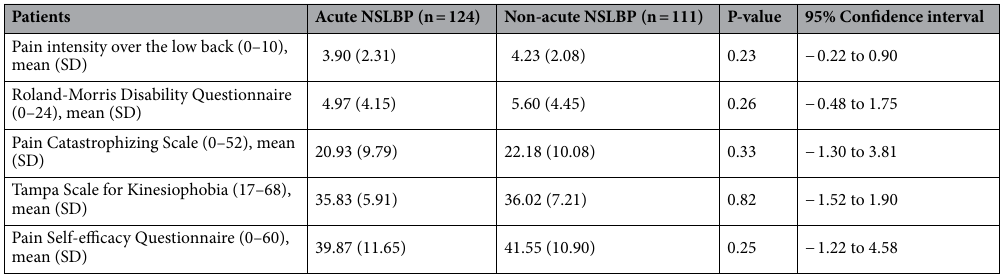
Table 2. Comparison of intergroup pain intensity, disability and psychosocial factors.